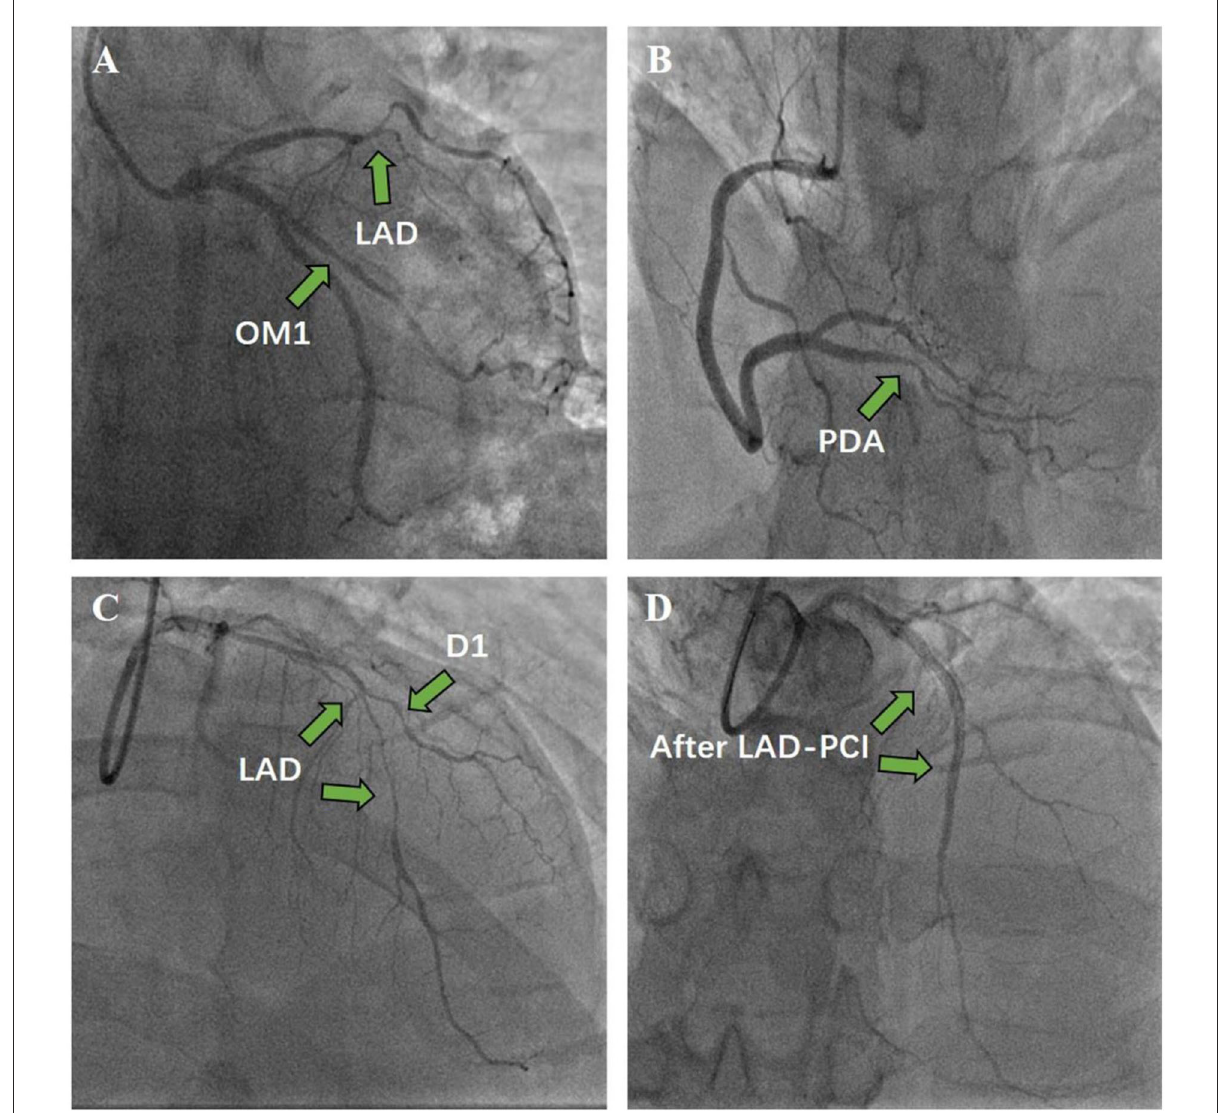
FIGURE4 Coronary angiography and percutaneous coronary intervention. (A) Left coronary angiography. (B) Right coronary angiography. (C) Before stent. (D) Two drug-eluting stents were implanted in the LAD to achieve